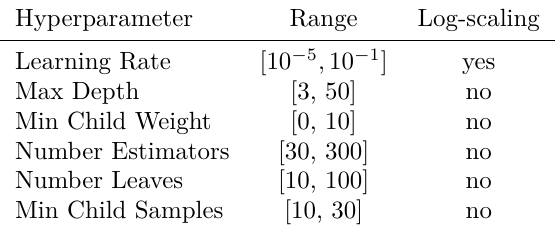
Table 3. Hyperparameters for training settings to- gether with ranges as used for Bayesian Optimisation of LightGBM